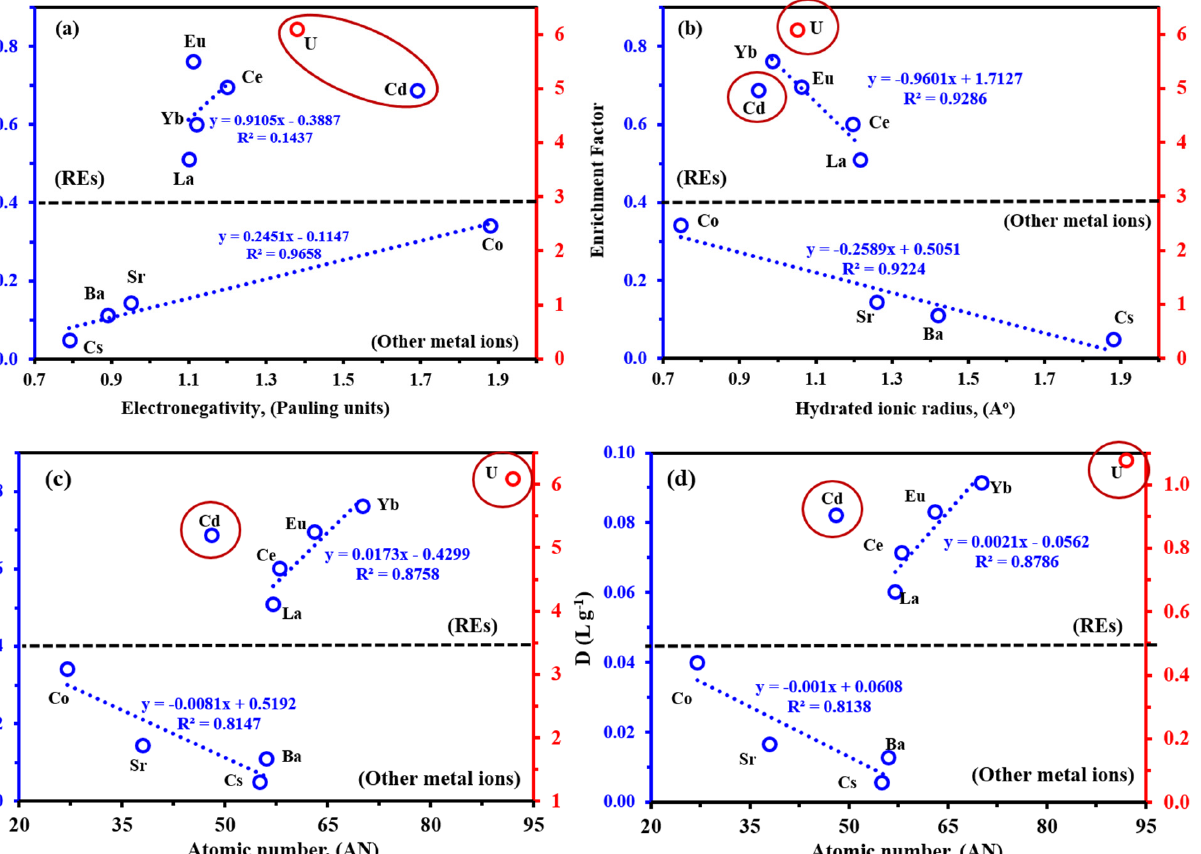
Figure 8. Correlation between atomic number and ( a ) enrichment factor and ( b ) distribution coeffi- cient (D). Enrichment Factor and electronegativity ( c ) and hydrated ionic radius correlations ( d ). Table 8. Chemical properties of some selected metal ions (under experiments).